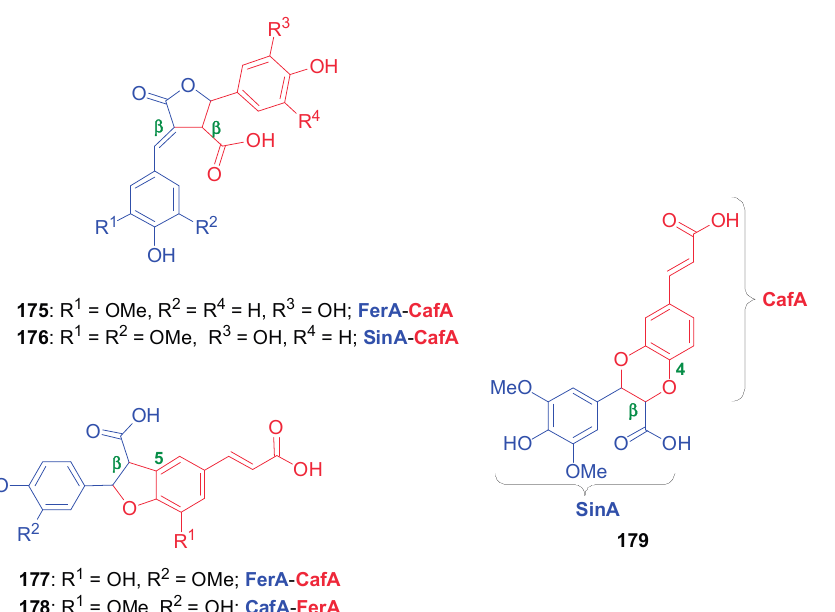
Figure 7. Major cross-coupled products from POC of pairs of HCAs using peroxidase-H 2 O 2 as